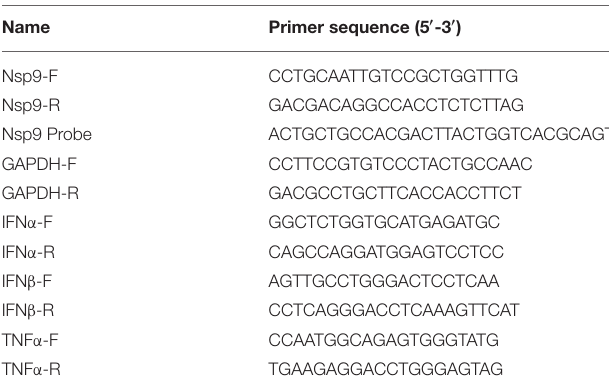
TABLE 1 | Real-time PCR primer